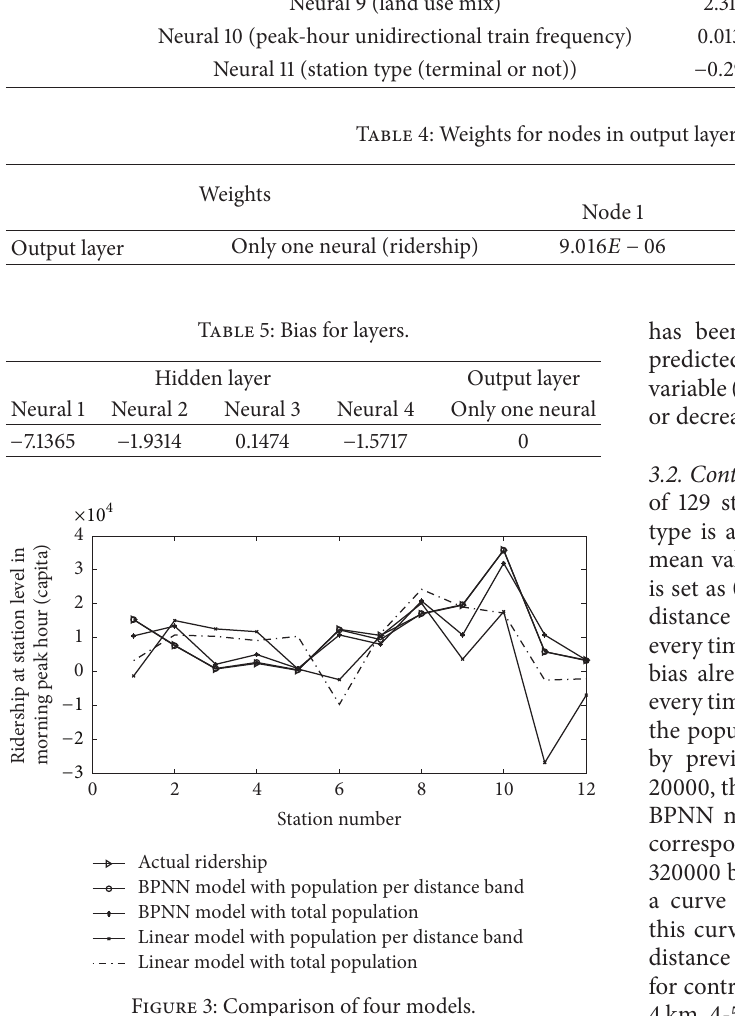
Figure 3: Comparison of four